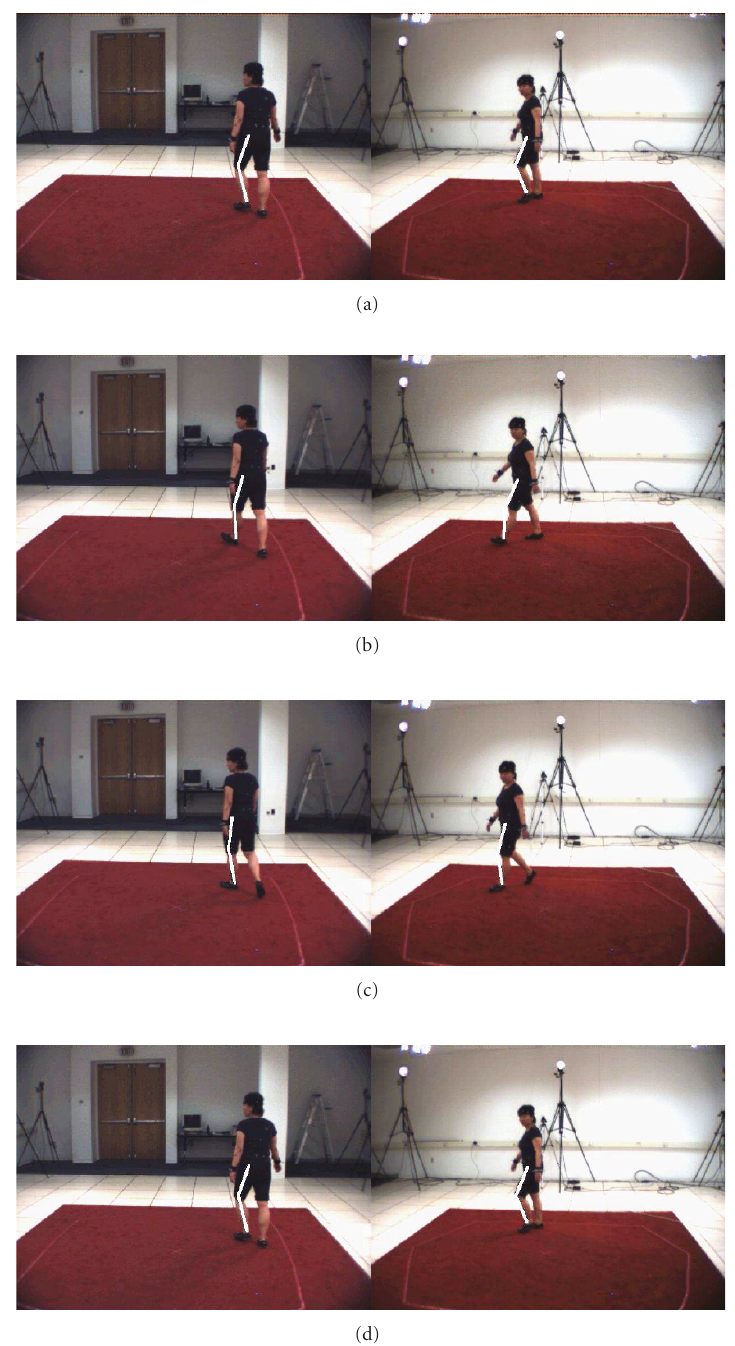
Figure 14: HumanEva walking sequence for the subject 1, applying Inverse kinematics